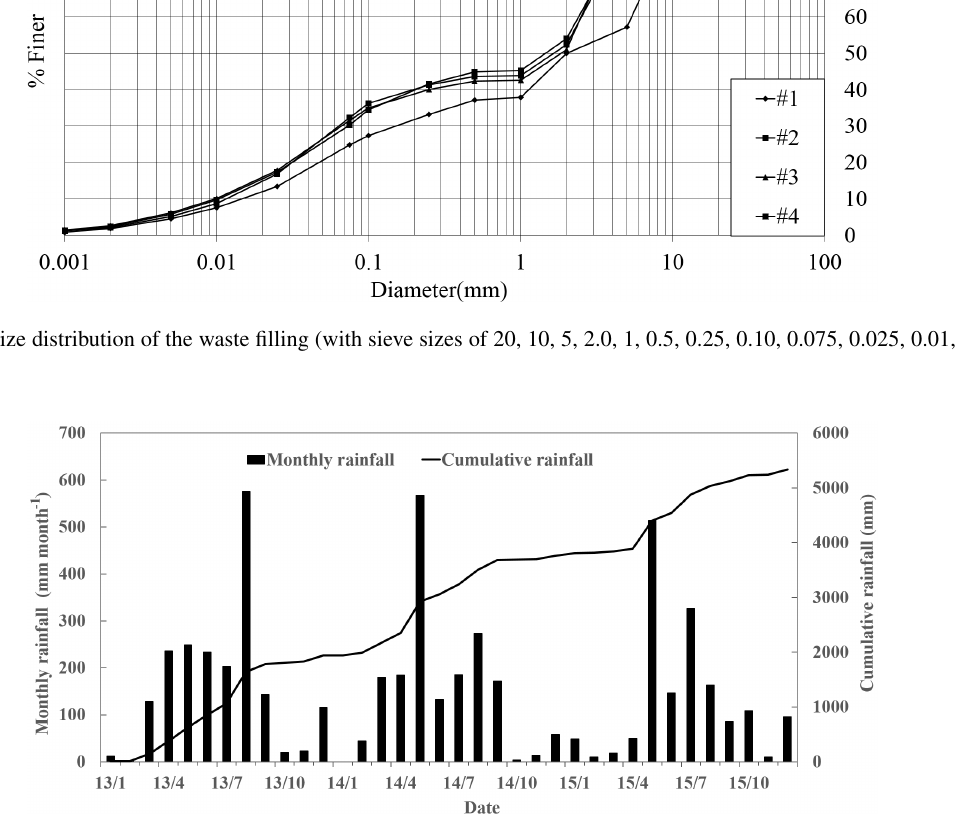
mitted (Fig. 6c), in addition to the concentration of